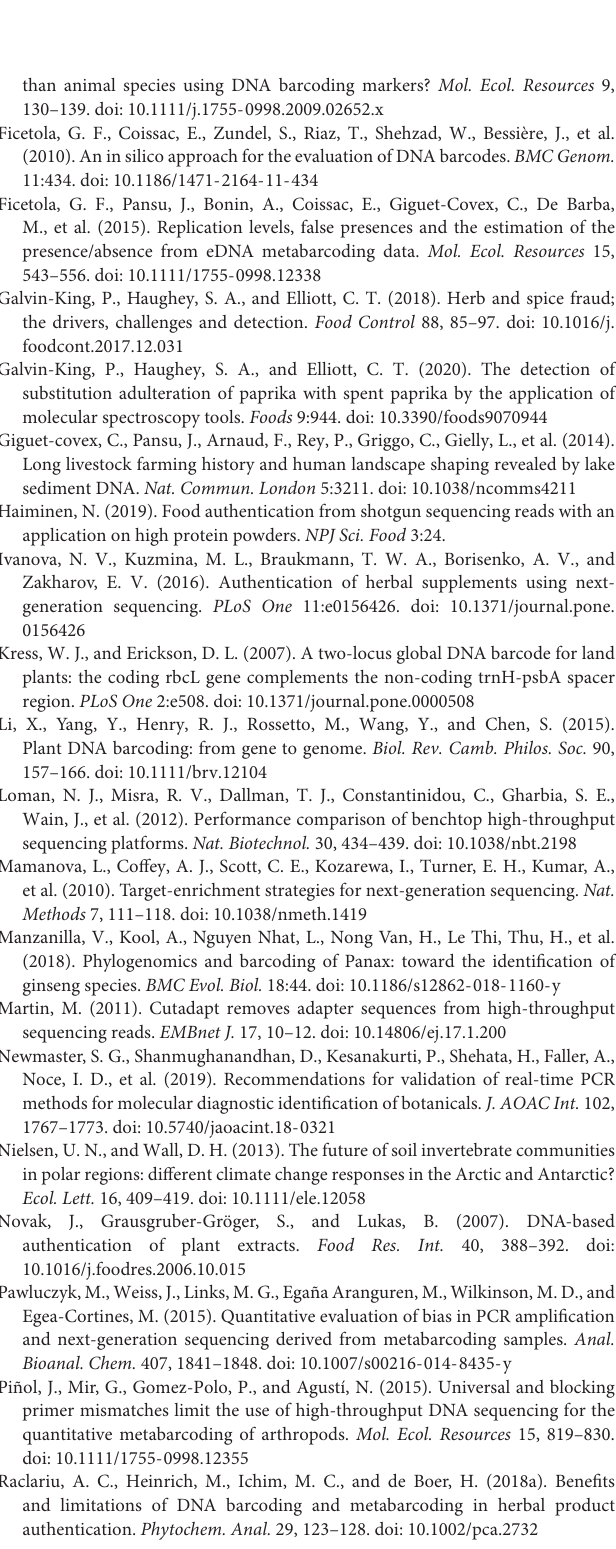
Supplementary File 2 | DNA gel electrophoresis